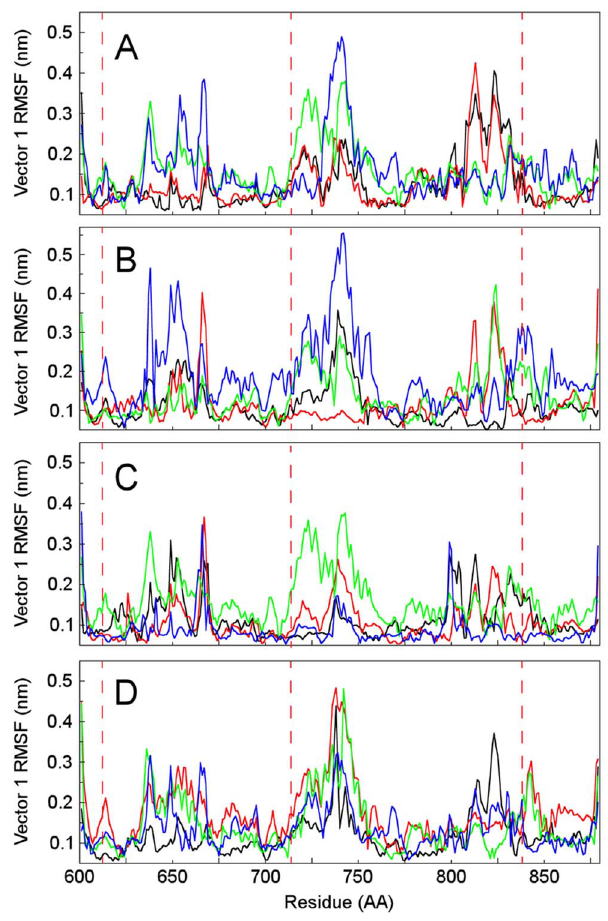
Figure 5. C a RMSF of the first eigenvector as a function of residue number. Black, NST; green, NSTLys614Ala; blue, NSTHi- s716Ala; red, NSTLys833Ala. A, N-sulfotransferase domain (NST) alone; B, NST-PAPS systems; C, NST-PAPS-GlcN-GlcA; D,